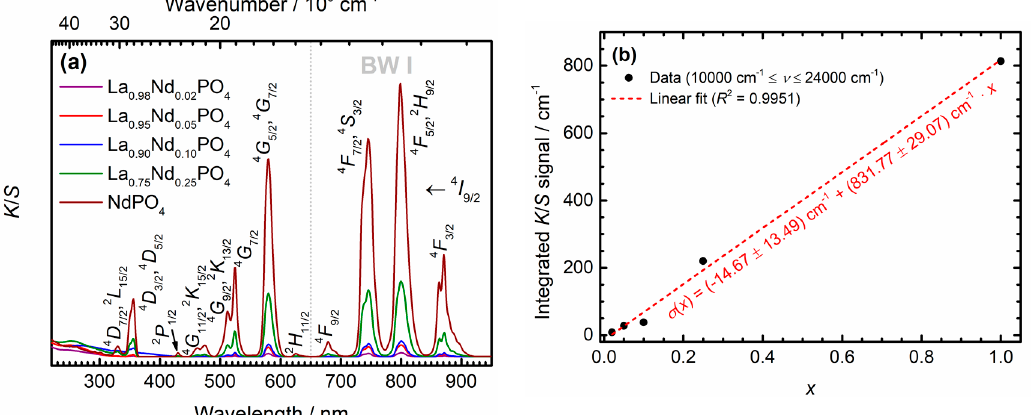
Figure 3. ( a ) Kubelka-Munk graphs of the La 1- x Nd x PO 4 ( x = 0.02, 0.05, 0.10, 0.25, 1.00) nanocrystals in powder form as obtained from the respective diffuse reflectance spectra (see Equation (1)). The respective assignment of the absorption transitions and the first biological window (BW I) are indicated. ( b ) Correlation between the Nd 3+ content x and the integrated absorption signal when evaluated in wavenumber scales. The red dashed line indicates a least-squares linear fit to the data. The intercept does not differ from zero at the statistical significance level of α = 0.05.